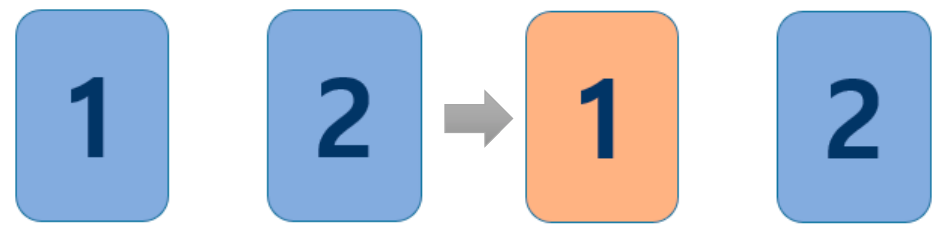
Figure 1. The first slide page ( left ) and when the audio for the first utterance is played ( right ).